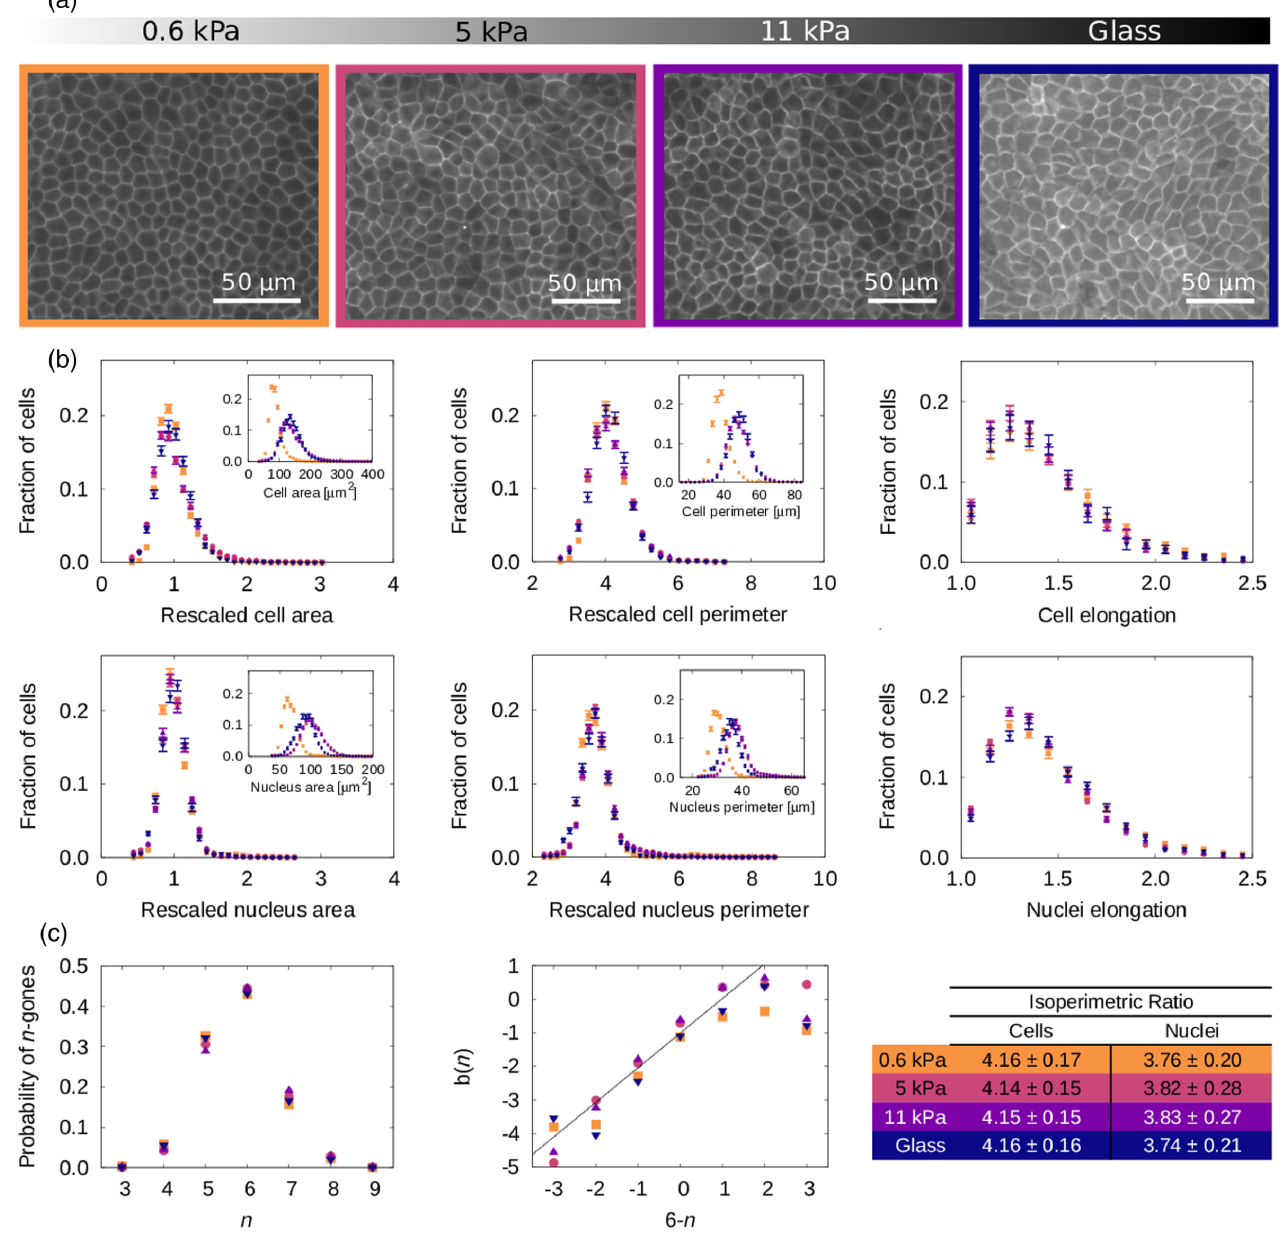
FIG. 2. Structure and topology of tissues in the homeostatic state. (a) Images of β -catenin stained cell membranes in the steady state H (inhibited for proliferation and locomotion). The magnification in different frames is chosen such that cells appear equally large, to PL visualize the morphological rescaling. (b) Distributions of morphological measures of cells obtained through set-based Voronoi tessellations (top row) and nuclei (bottom row). For soft gels (orange) 4257 cells are extracted from large colonies to avoid finite-size effects. For tissues grown on 5 kPa (pink), 11 kPa (purple), and glass (blue) substrates, 9095, 5244, and 2575 cells are considered. The distributions of rescaled measures (each length divided by the square root of the mean area) are provided as main graphs, while the insets show the original data. Distributions for area (left), perimeters (middle), and elongations (right) are shown. Elongations are extracted by calculating the principle axis of inertia of the relevant object (cell or nucleus) and finding the ratio. Error bars correspond to the standard deviation on 50 independent subsets of cells (see Appendix C). (c) Conservation of topological measures relative to tissues grown on different substrates. The color code is consistent throughout the figure. Distribution of cells with n sides (i.e., neighbors) is on the left, while, in the center, the Aboav-Weaire ’ s law is measured through the parameter b ð n Þ ¼ h m ð n Þi n − 6 n − σ 2 isoperimetric ratios for the average cell and nuclei shapes are provided in the table on the